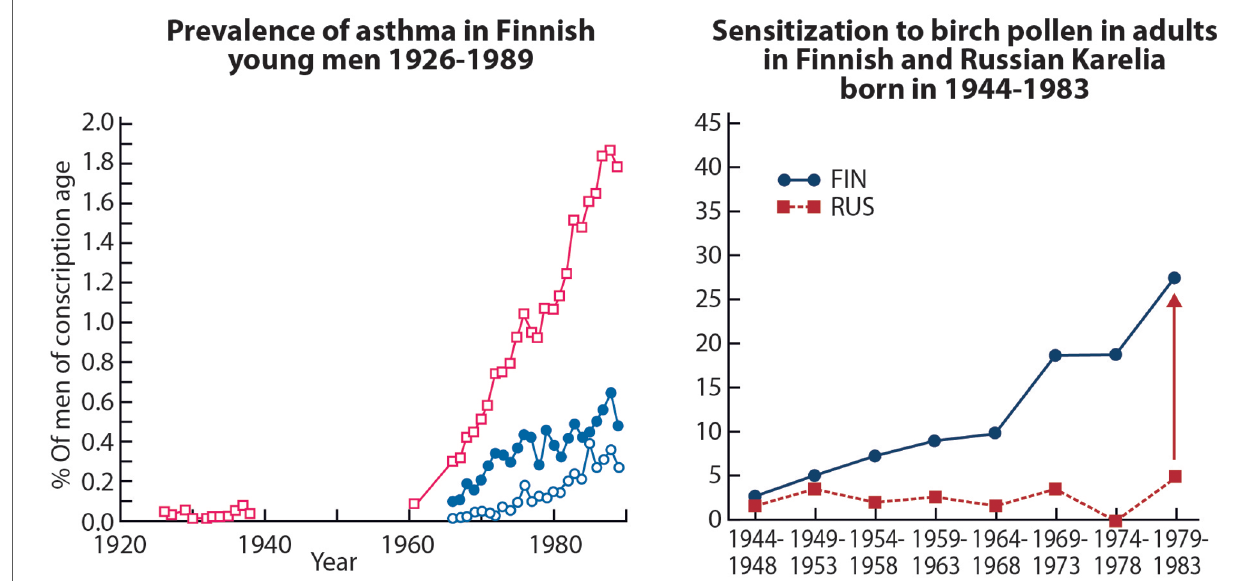
FIGURE 2 Left panel, asthma prevalence in the Finnish conscripts 1926 – 1989 (21). Two lower curves indicate percentages of men exempted at call-up medical examination because of asthma (closed circles), and those discharged during course of the service (open circles). Right panel, generational increase in positive allergen speci fi c IgE levels to birch pollen in the Finnish but not in the Russian Karelia (22). Among older generations, born in the 1940s, the prevalence was at the same low level in Finnish vs. Russian Karelia. Adopted from Ref.